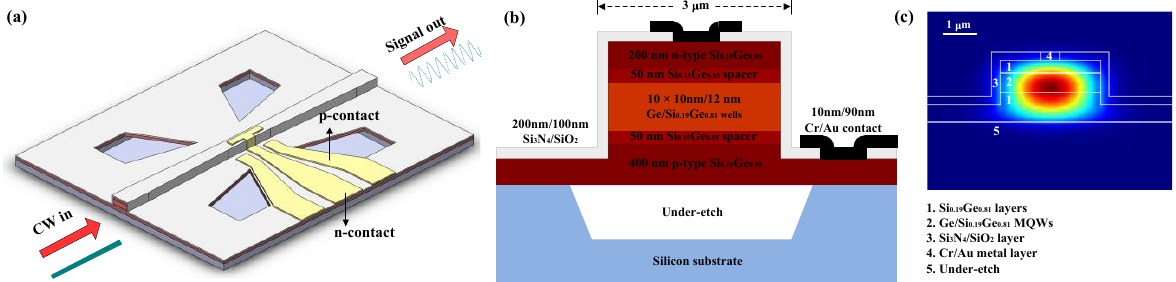
Figure 1: (a) Schematic of the device. (b) Epitaxy design of the multiple quantum wells (MQWs) structure. (c) The fundamental mode of the suspended